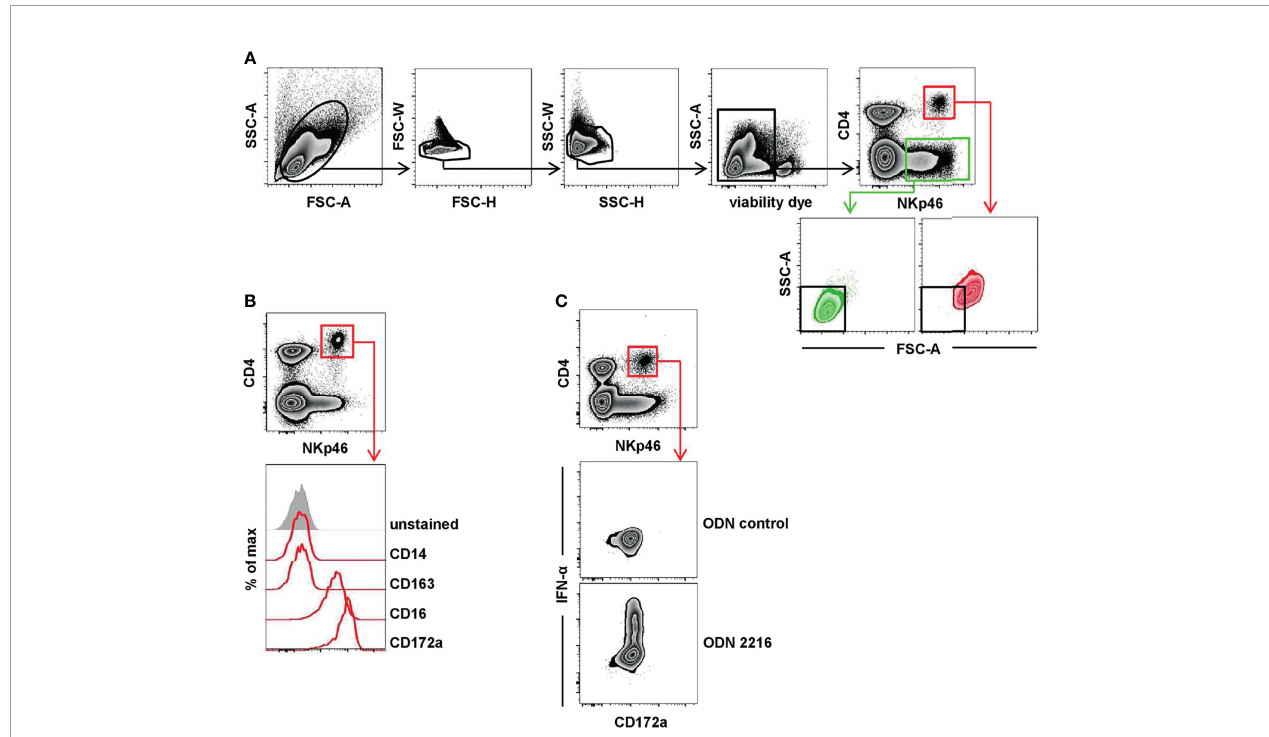
FIGURE 1 | Porcine CD4 high CD172a low pDC express NKp46. (A) Total PBMC were gated according to their light-scatter properties. Potential doublet cells were excluded by consecutive FSC-H/FSC-W and SSC-H/SSC-W gates, followed by gating on cells negative for the viability dye VDeFluor780 to exclude dead cells. Within live PBMC, two NKp46 + cell subsets were separated according to their CD4 co-expression: CD4 + NKp46 + (red gate) and CD4 - NKp46 + (green gate). CD4/ NKp46-de fi ned subsets were backgated and analyzed for their light-scatter properties. (B) CD4 + NKp46 + cells derived from blood (red gate) were analyzed for co- expression of different monocyte/DC-associated surface markers by multicolor FCM. Expression pro fi les of CD14, CD16, CD163, and CD172a of CD4 + NKp46 + cells from one representative animal are shown as red open histograms. Unstained control is shown as tinted gray histogram on the top. (C) PBMC were stimulated